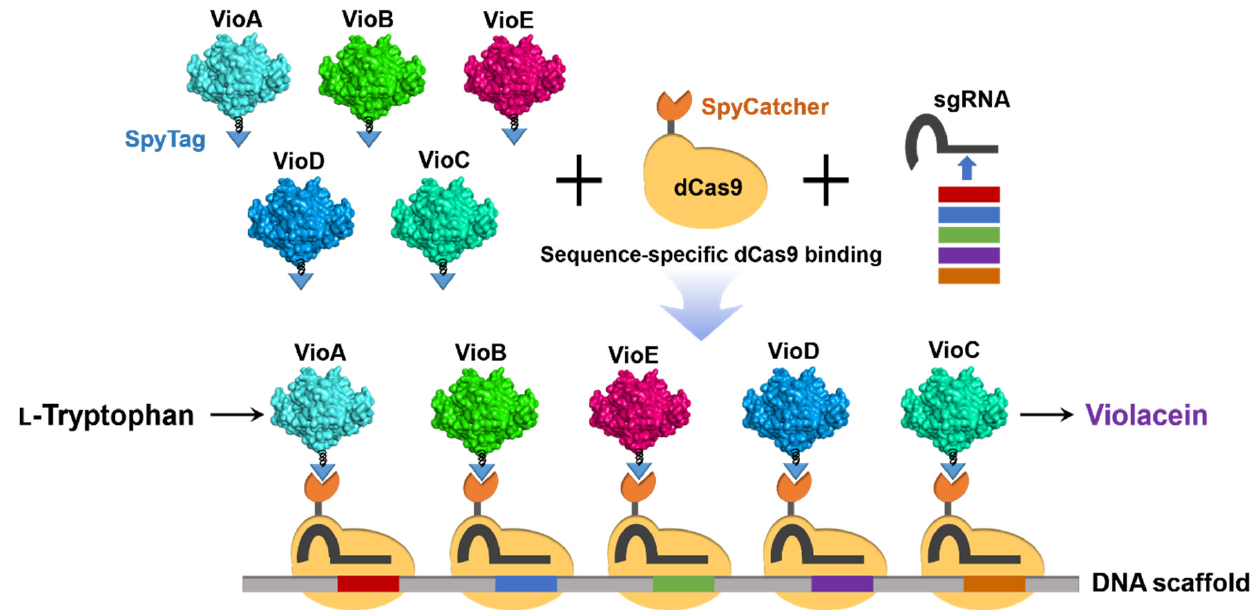
Figure 3. CRISPR/dCas9 directed nanometric assembly of enzymes. Violacein biosynthetic enzymes are covalently ligated to dCas9 via the SpyTag/SpyCatcher mediated isopeptide bond formation. Complex formation of the enzyme conjugated dCas9 ′ s with guide RNAs (sgRNA) allows for the programmable arrangement of five violacein biosynthetic enzymes (VioA-E) on a DNA scaffold with sgRNA specific target sequences [50].